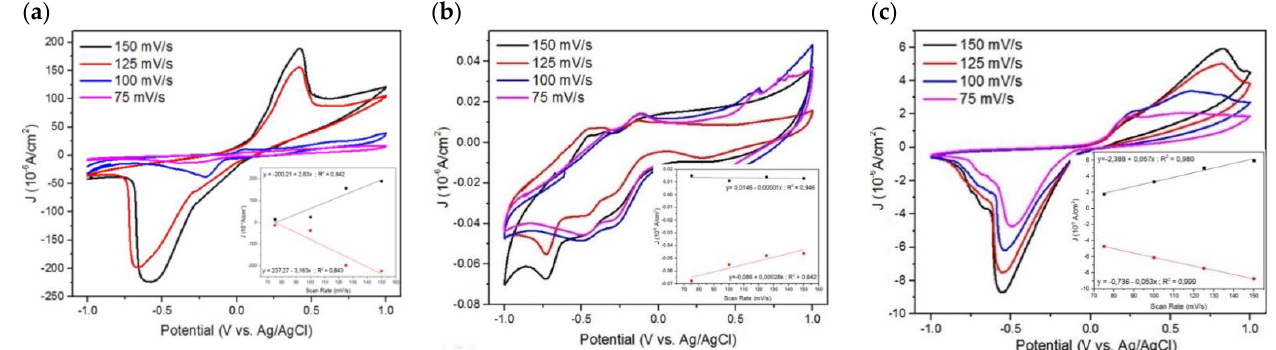
Figure 8. The experiment results of the CV measurement and peaks of oxidation and reduction currents as a function of scan rate on ( a ) the Ag thin-film electrode deposited using DC sputtering, ( b ) the Ag thin-film electrode deposited using spin coating, and ( c ) the Ag nanosquare array electrode.